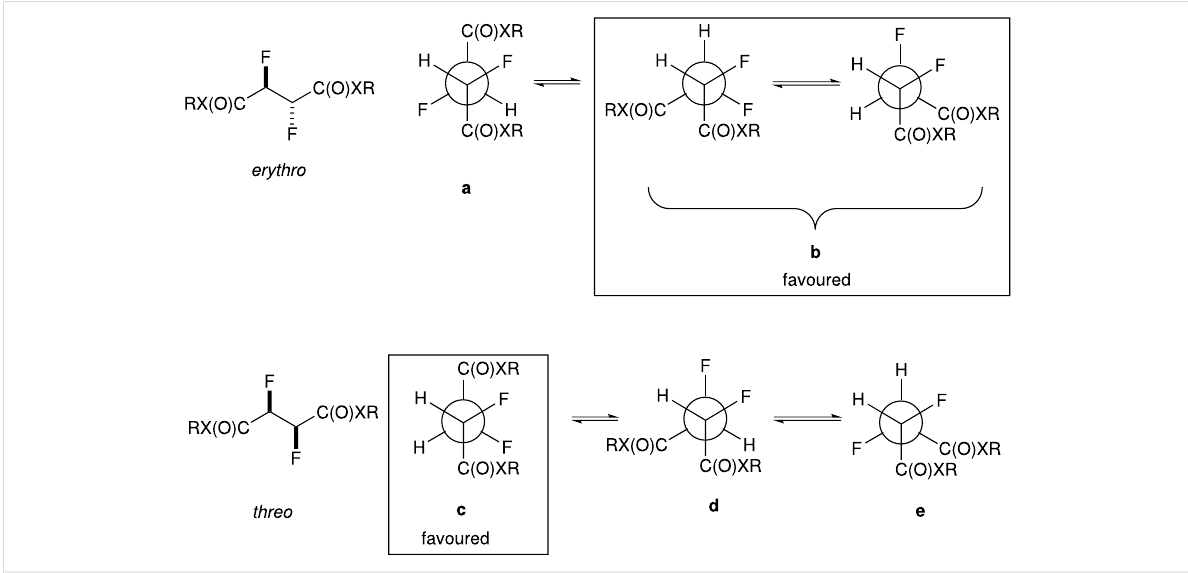
Figure 16: Newman projections of the three staggered conformations of the erythro and threo stereoisomers of the vicinaldifluoro compounds succin- ates.